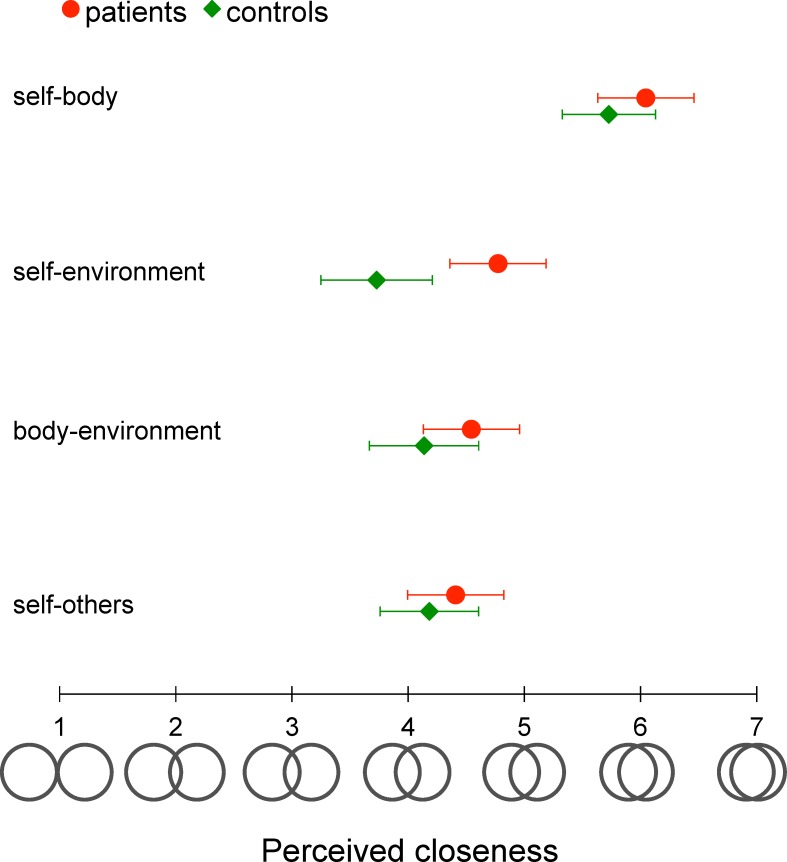
Subjective measures of self-body anchoring (Experiment 3).Pictorial descriptions used to measure the closeness between the self, body, environment and others. Seven pairs of circles shown at the bottom of the figure were presented to participants, who had to indicate which one better represented the perceived degree of “closeness” between two items, such as the self and body. Colored symbols represent the mean of self-reports from patients and controls and horizontal bars represent the standard error of the mean.